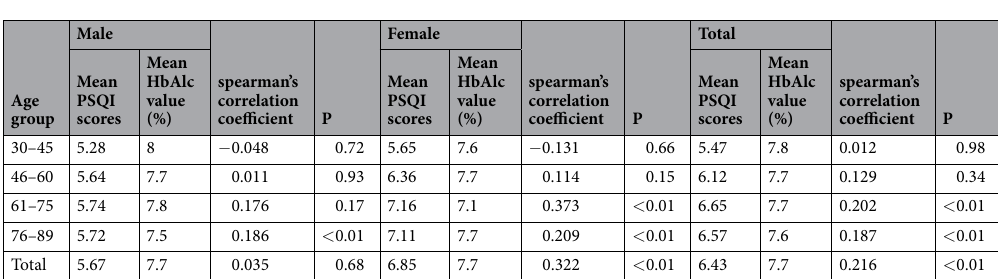
Table 2. Relationships between subjective sleep status and HbAlc according to gender and age at baseline. P values were obtained using analysis of the spearman’s correlation analysis.